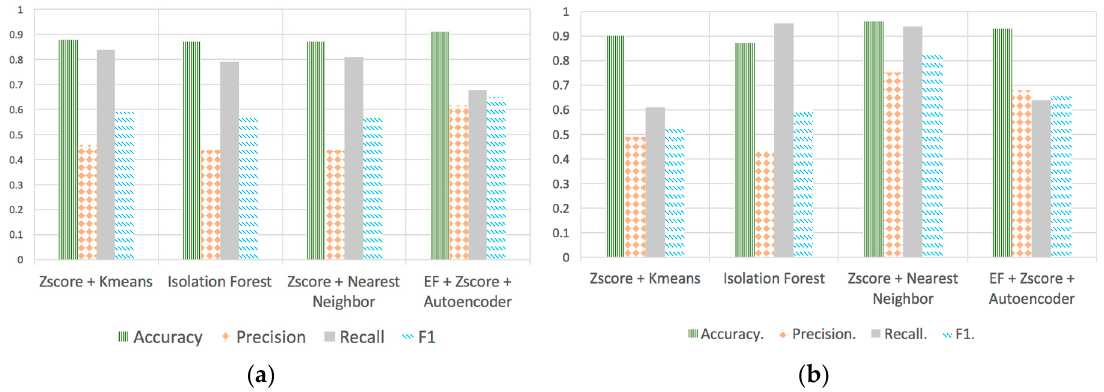
Figure 2. Anomaly detection results in ( a ) NSL-KDD and ( b ) ISCX